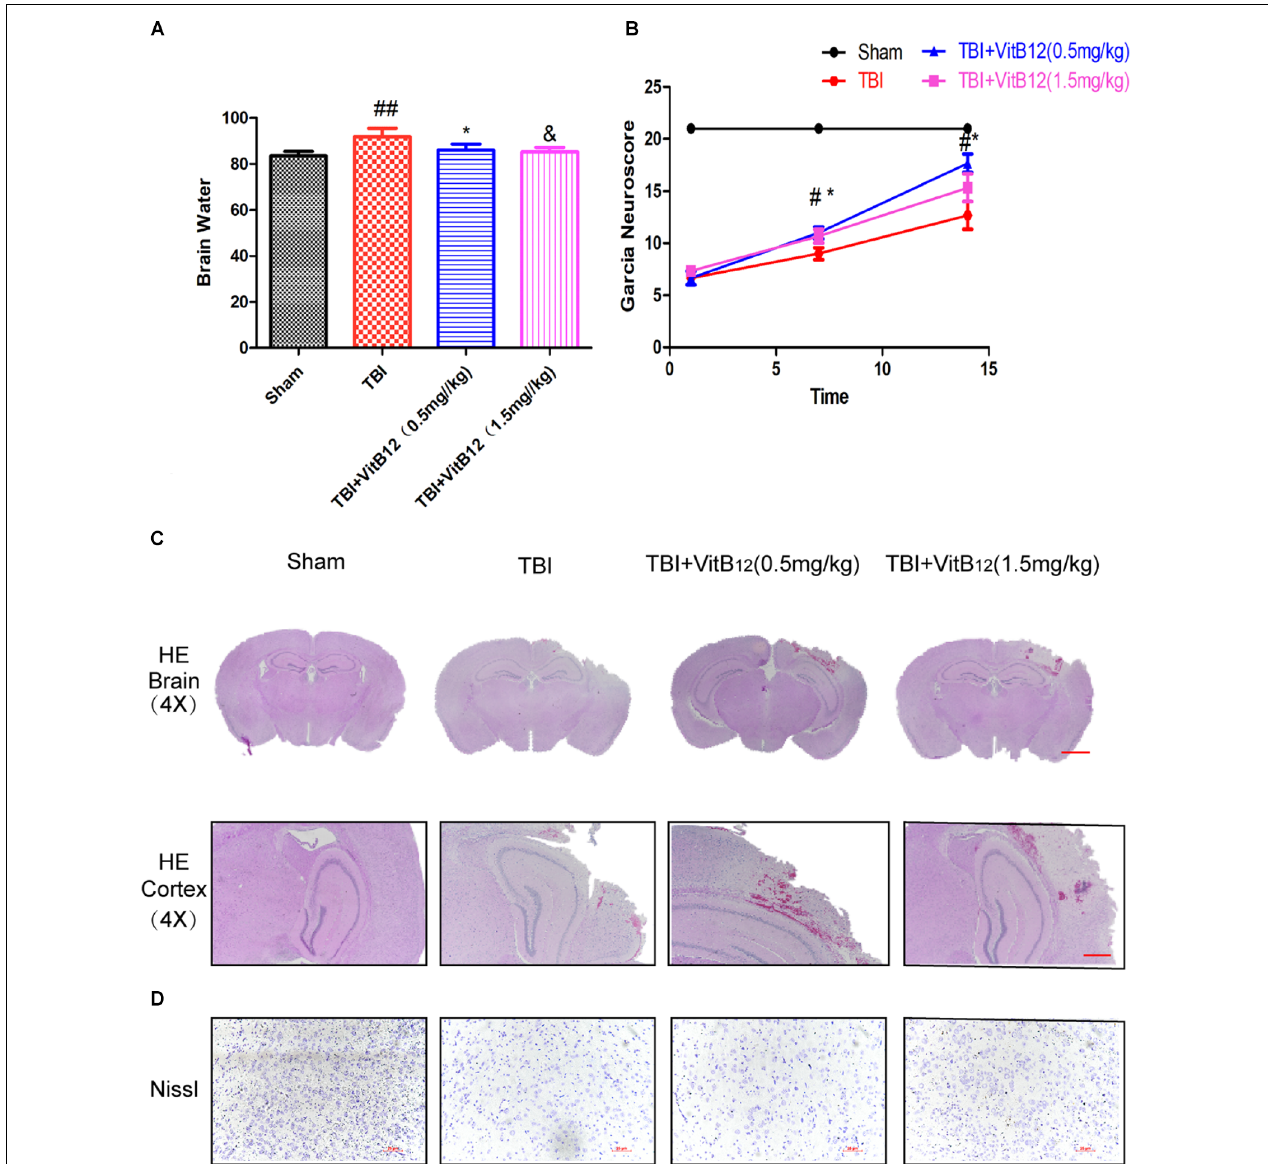
FIGURE 1 | Vitamin B12 treatment reserves tissue structure damage and protects functional recovery after TBI. (A) Quantification of brain water content in the ipsilateral brain cortex at 1 day after TBI. ## P < 0.01 vs. the sham group. ∗ P < 0.05 and & P < 0.05 vs. the TBI group values represent the mean ± SEM, n = 6. (B) Garcia test evaluation at 7 days, 14 days after TBI. # P < 0.05 vs. the sham group. ∗ P < 0.05 vs. the TBI group values represent the mean ± SEM, n = 5. (C–D) Representative images of H&E and Nissl staining in the cortex at 14 days